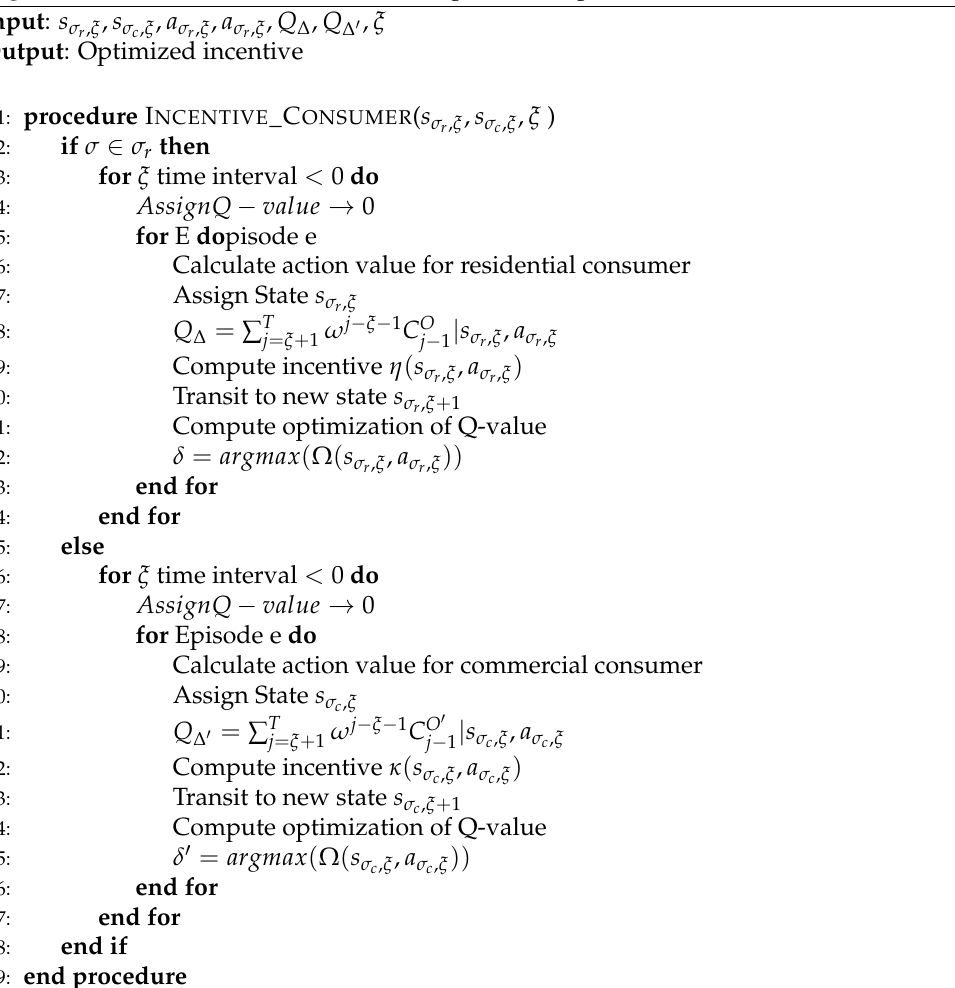
Algorithm 1 Incentive for Consumers using